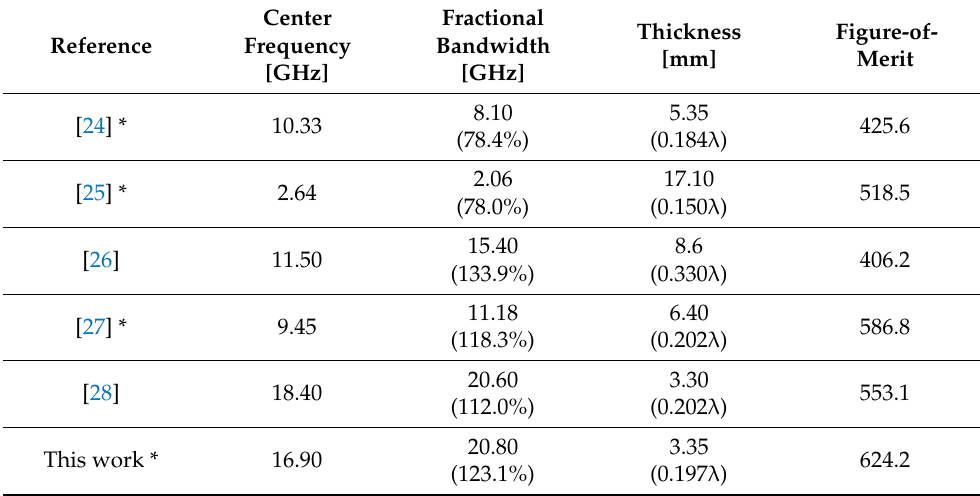
Table 1. Comparison table of the ITO film-based absorber. The values from the measurement are marked with an asterisk. The values without the asterisk are from the simulation. All works in this table are transparent. The figure-of-merit is calculated as the ratio of the fractional bandwidth to the electrical